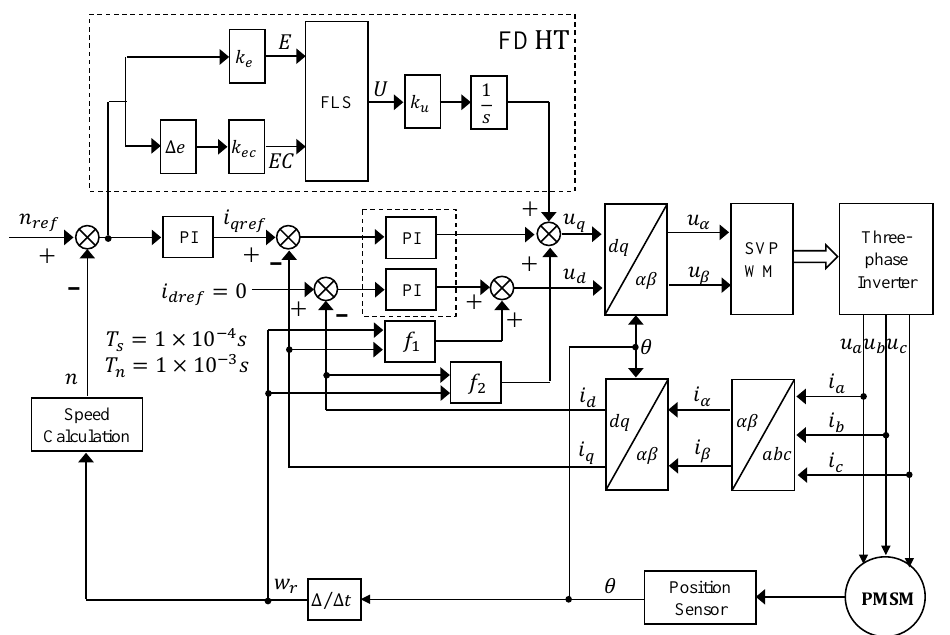
Figure 11. Structure of the PMSM vector control system applying FDPI-FDHT.